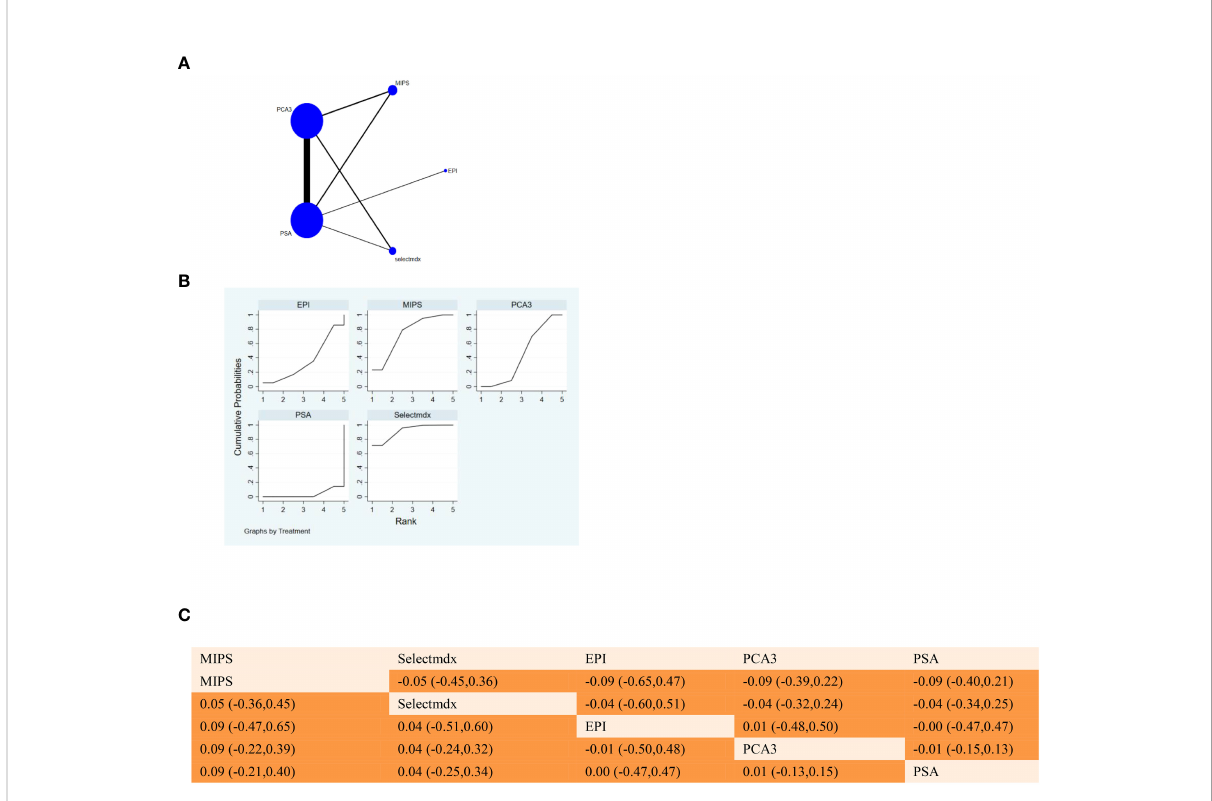
FIGURE 3 Proportion of risk of bias for all domains. (A) NMA fi gure for SE. (B) SUCRA plot for Sensitivity. (C) League table on